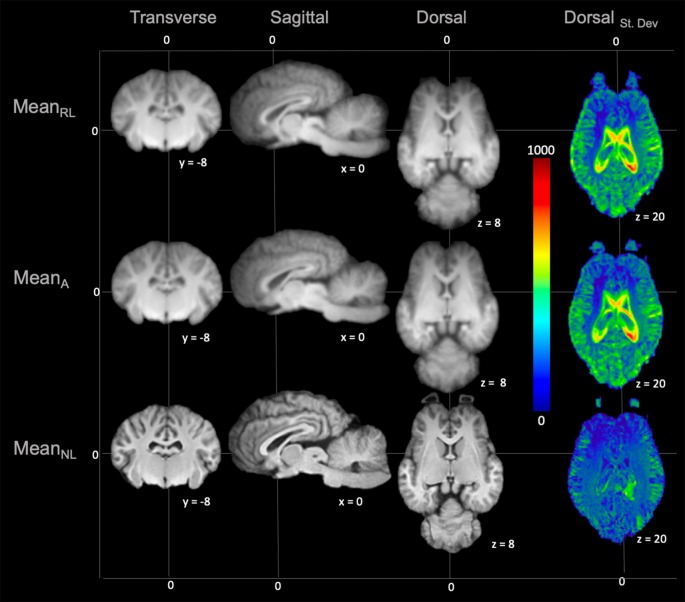
Demonstrates the rigid linear (MeanRL), affine (MeanA) and non-linear (MeanNL) templates in mid transverse, mid sagittal and mid dorsal planes. The non-linear template (MeanNL) has clearer boundaries between structures and exhibits better GM and WM definition, when compared to the rigid linear (MeanRL) and affine (MeanA) templates. The corresponding standard deviation (blue = 0 and red = 1,000) for each template is demonstrated in mid dorsal plane on the right column. This shows that there is a reduced standard deviation in the non-linear (MeanNL) template than the other templates.